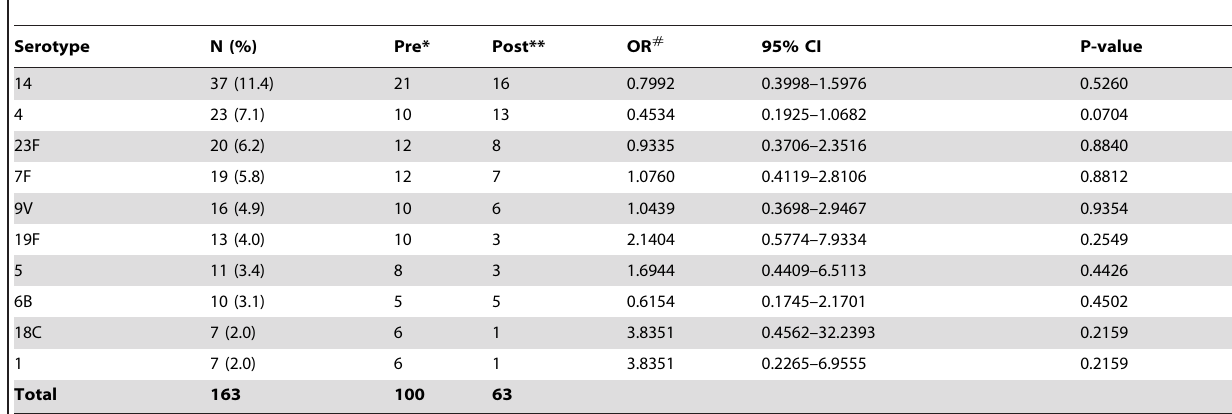
Table 1. Distribution of serotypes belonging to PCV10 among invasive pneumococci recovered from 2007 to 2012 (the distribution of all serotypes is demonstrated on the Table S1).